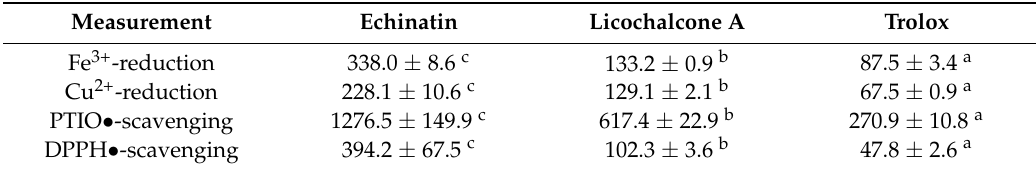
Table 1. IC 50 values ( µ M) of echinatin and licochalcone A from the four sets of antioxidant colorimetric